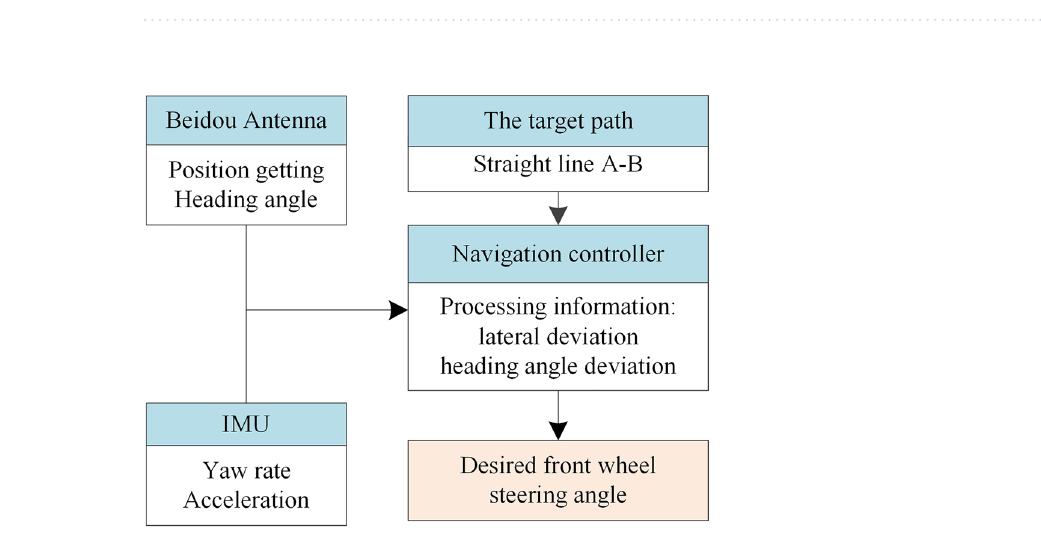
Figure 5. Block diagram of the overall system control scheme.